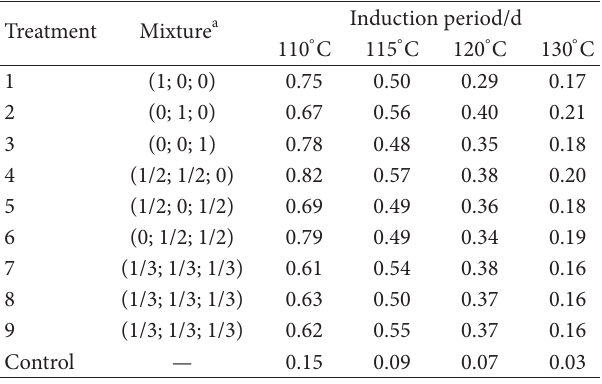
T 6: Induction period values (in days) obtained through Ranci- mat method, according to simplex-centroid design of